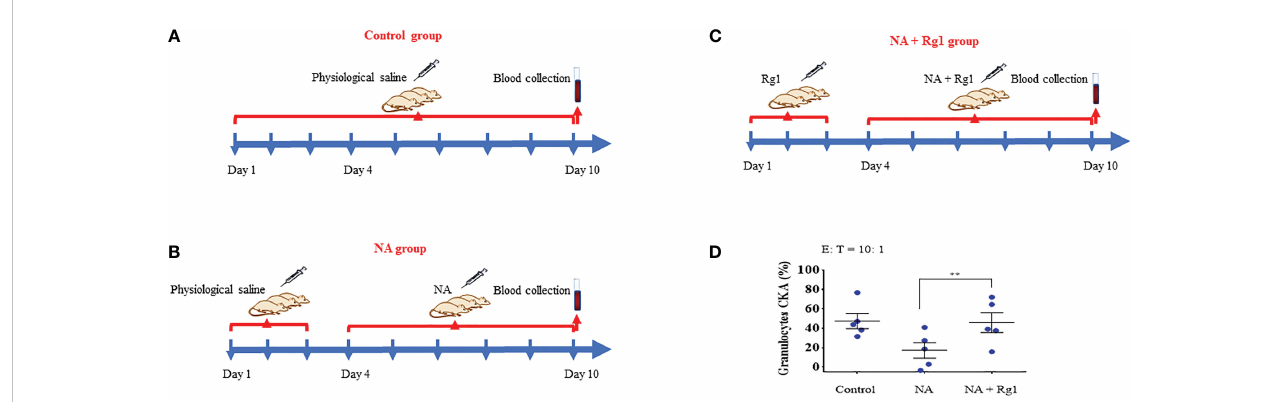
FIGURE 3 In the ex vivo test, ginsenoside Rg1 could improve the cancer-killing ef fi ciency of rats granulocytes immunosuppressed by noradrenaline (NA). (A - C) Detection of the effect of ginsenoside Rg1 on the cancer-killing ef fi ciency of granulocytes in rats immunosuppressed by NA. (D) Effect of ginsenoside Rg1 (20 mg/kg) on the cancer-killing ef fi ciency of granulocytes immunosuppressed by NA in rats (n = 5; mean ± SD; two-tailed student ’ s t-test; **, P <